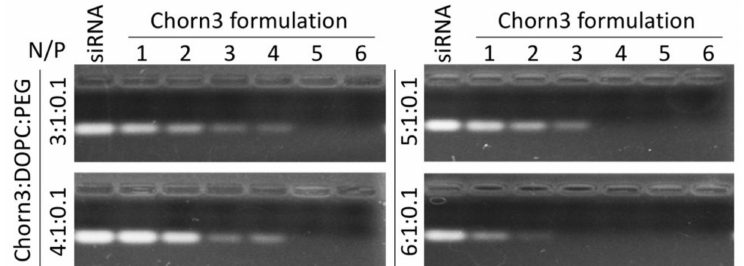
Figure 3. Chorn3 formulations bind to siRNA and form nanoparticles. Electrophoresis mobility shift